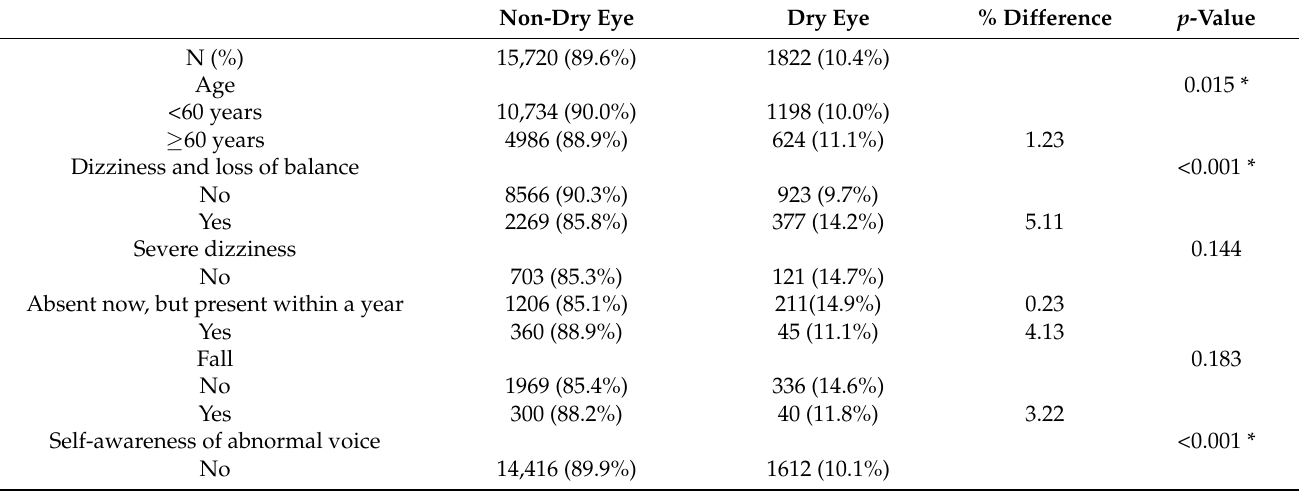
Table 1. Clinical characteristics according to dry eye in the study